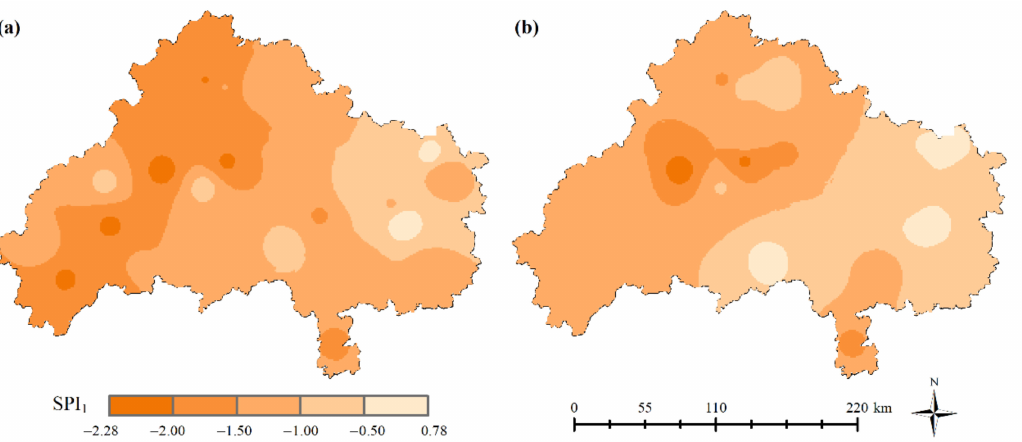
Figure 13. Spatial patterns of SPI 1 ( a ) before and ( b ) after artificial rainfall operation in HSDC in August